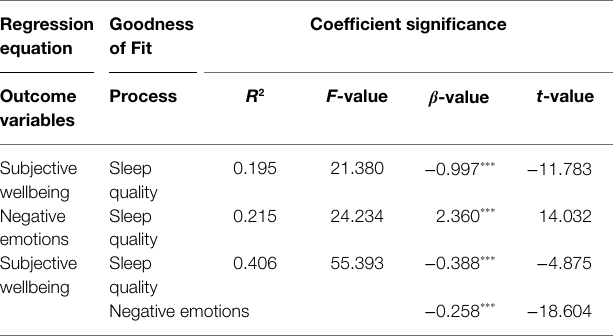
TABLE 2 | Mediating effects of negative emotions between sleep quality and subjective